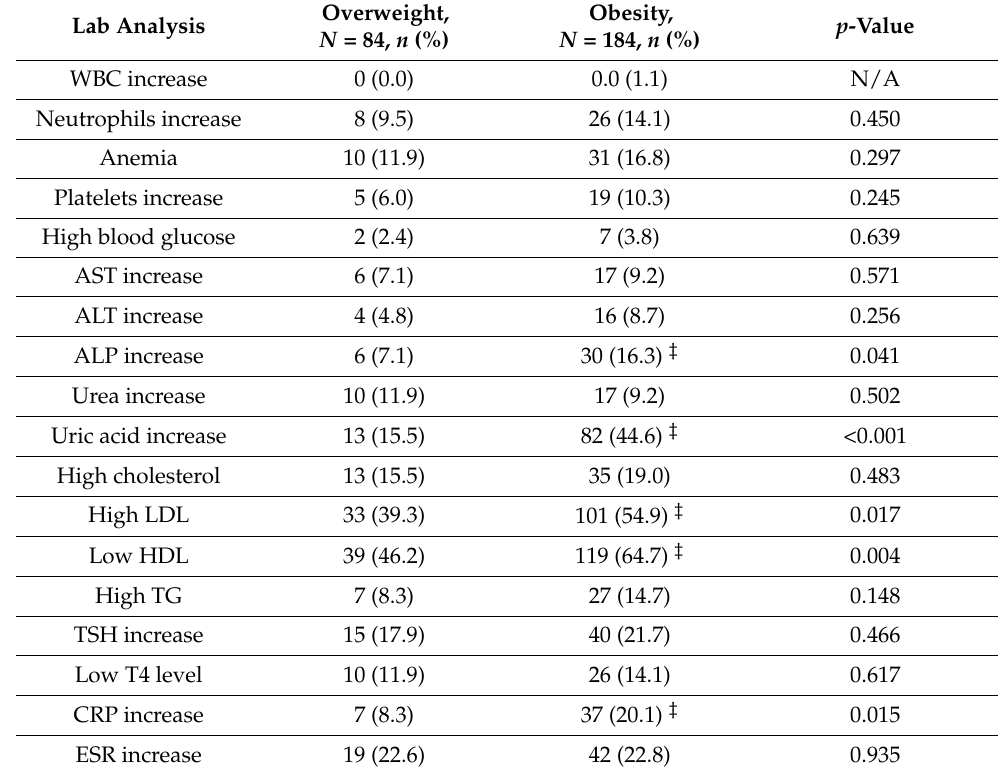
Table 4. Laboratory findings according to type of excess body